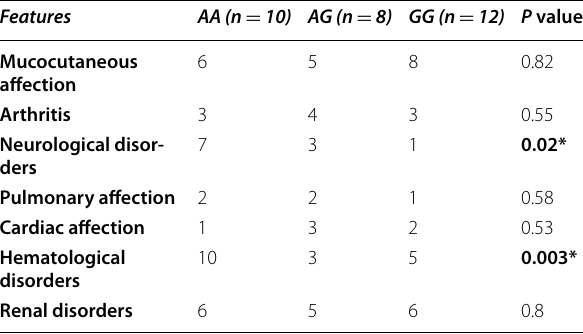
Data were analyzed using the Fisher’s exact test *Significant difference at P